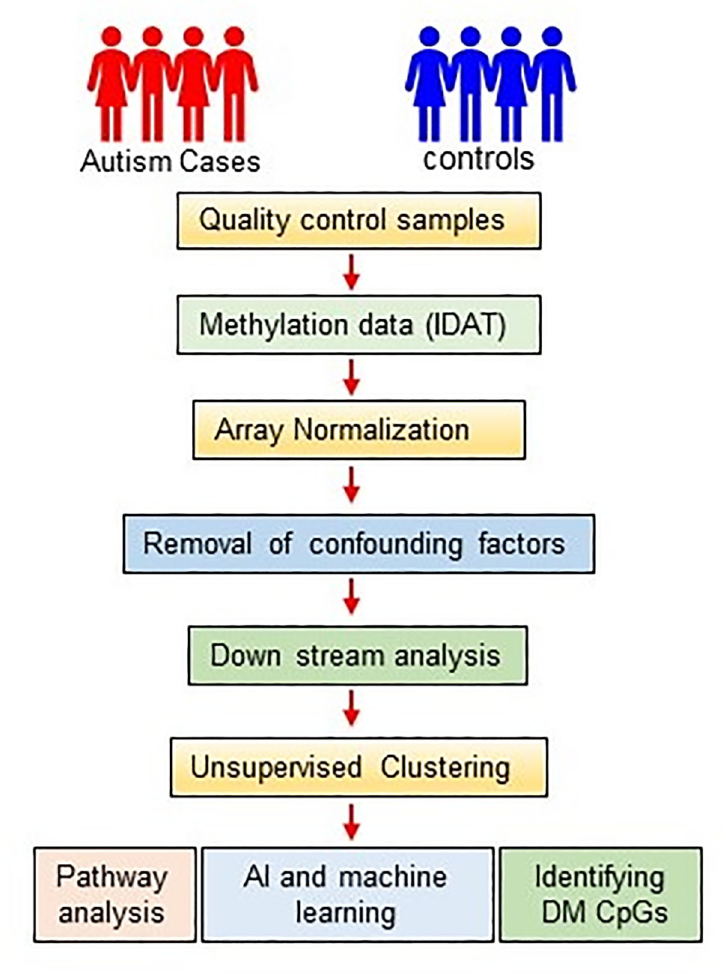
Fig 1. Schematic summary of the methylation array data processing and analysis